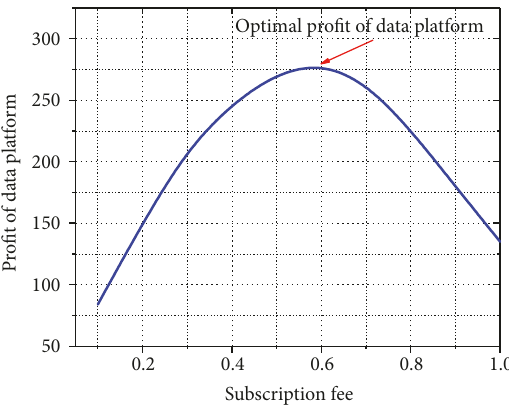
Figure 8: Data platform profit under different quality level